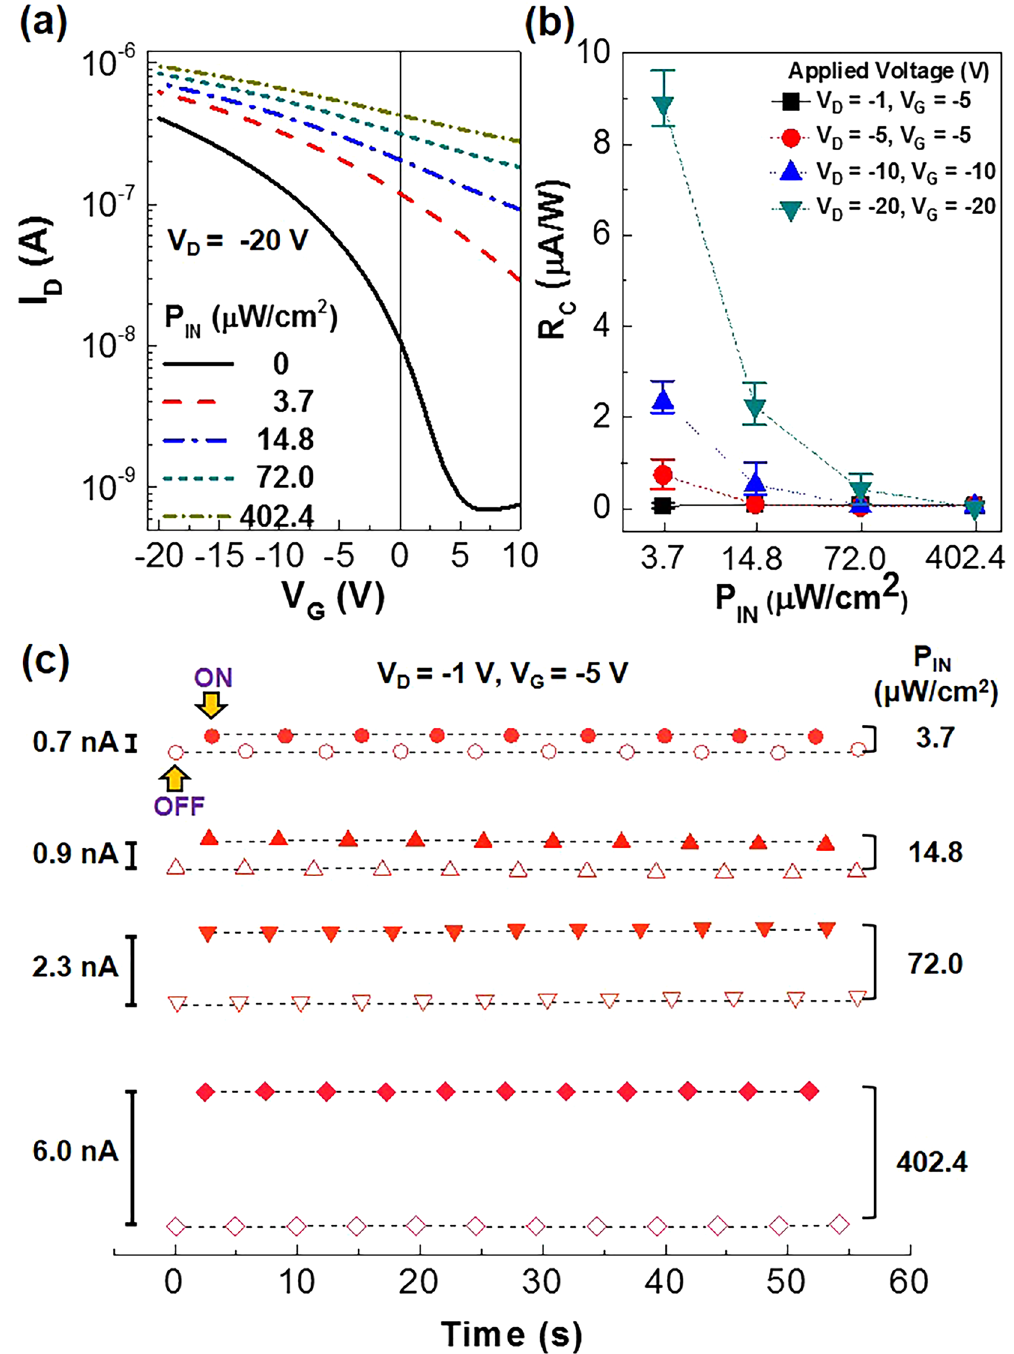
Figure 4. Photosensing performances under visible light (550 nm). ( a ) Change of transfer curves according to the incident light intensity (P IN ) of green light (550 nm) for the flexible PDLC-i-OFET devices. ( b ) Corrected responsivity (R C ) as a function of P IN (note that more than sixteen devices were measured). ( c ) Stable drain current response by continuous operation of the flexile PDLC-i-OFET devices under visible light (550 nm) with different P IN